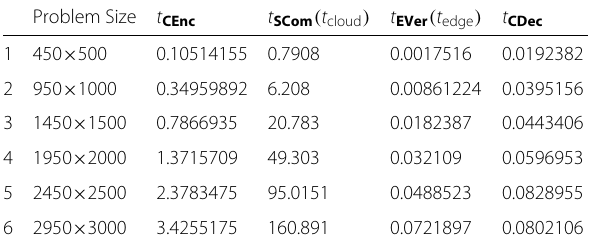
Table 3 Ax ≡ b mod 251 with parameters